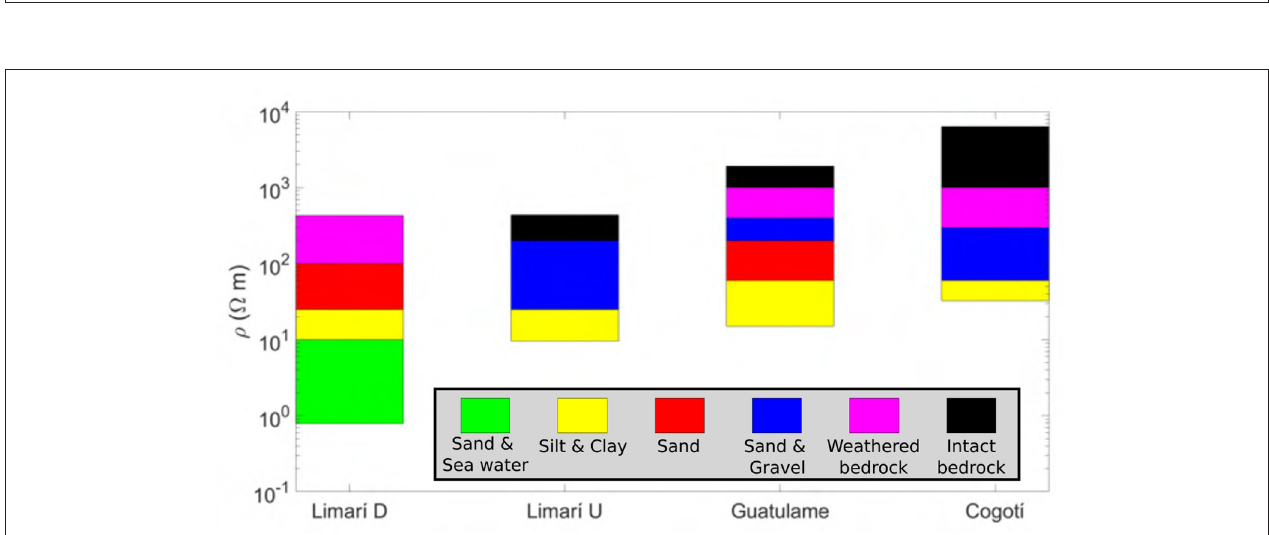
FIGURE 9 | Example of correlation between main lithological materials and resistivity intervals for the four sectors of hidrogeological continuity presented in Figures 7 , 10 . The sectors are presented in a increasing topographic order. The letter D stands for Downstream of the element of discontinuity (refer to section 3.1).